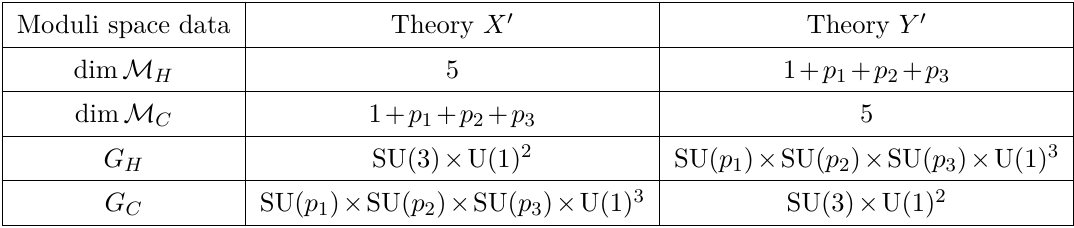
Table 8 . Summary table for the moduli space dimensions and global symmetries for the mirror pair in figure